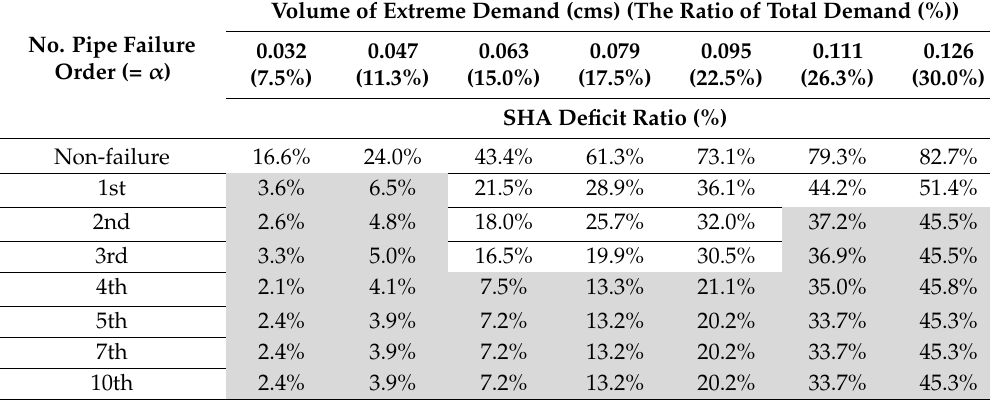
Figure 3. Mechanical redundancy (SHA) deficit ratio for different orders of pipe failure. Table 5. Mechanical redundancy (SHA) deficit ratio for different orders of pipe